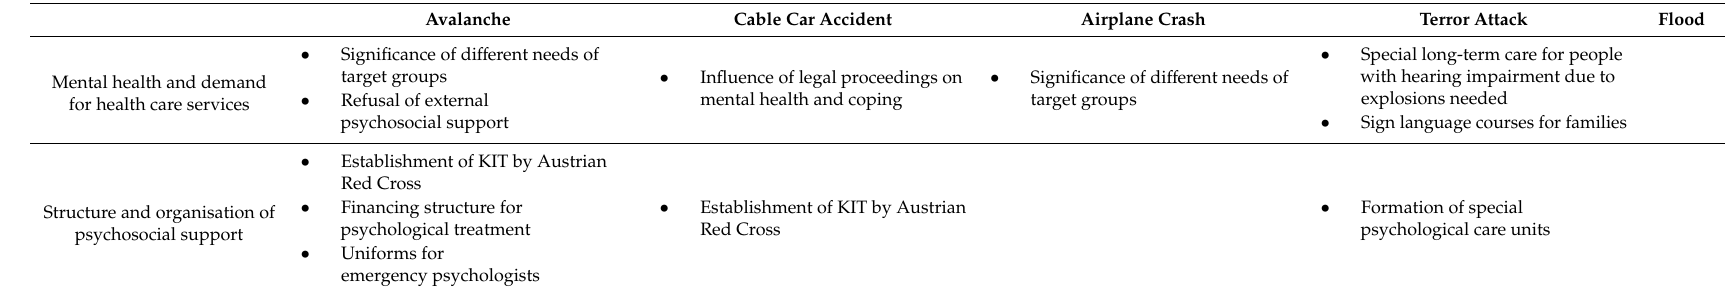
Table 2. Overview of long-term impacts on health-system performance.